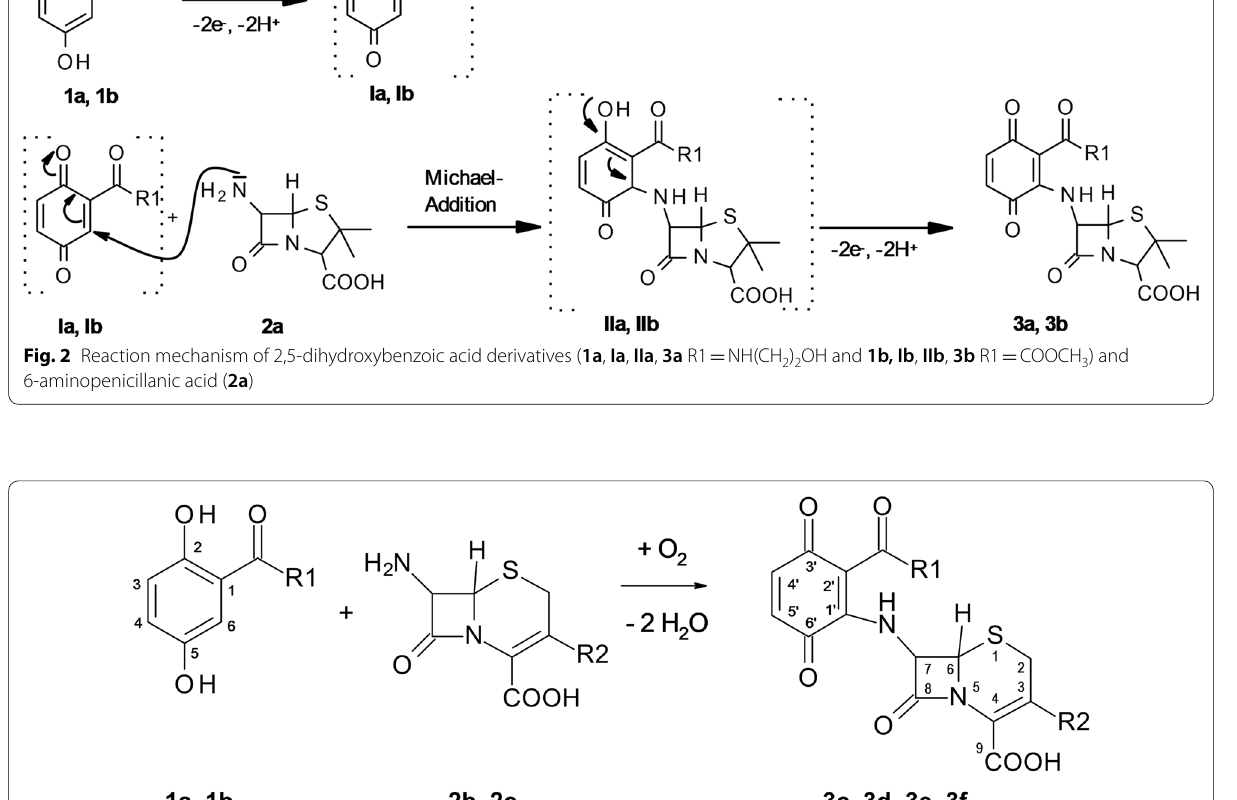
NH(CH 2 ) 2 OH and 1b R1 COOCH 3 ), 7-aminocephalosporanic acid ( 2b R2 = = CH 3 ) and the products 3c (R1 NH(CH 2 ) 2 OH, R2 = = CH 3 ) and 3f (R1 COOCH 3 , R2 CH 3 = = =